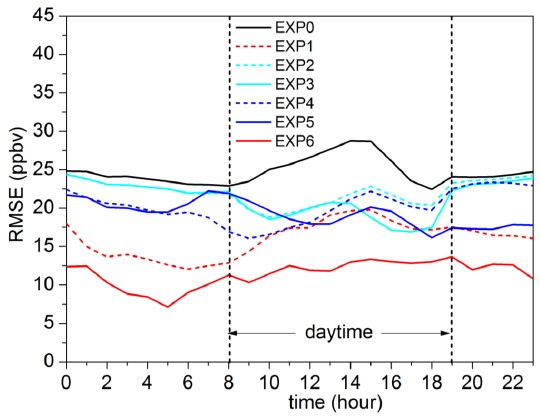
Fig. 9. Daily variation of the RMSEs of 1-hour ozone forecast in EXP0 (free run), EXP1 (adjusting ozone initial conditions only), EXP2 (adjusting VOCs initial conditions only), EXP3 (adjusting VOCs emission rates only), EXP4 (adjusting NOx initial conditions only), EXP5 (adjusting VOCs emission rates only) and EXP6 (adjusting ozone initial conditions and precursor NOx, VOCs initial conditions and emission rates jointly).